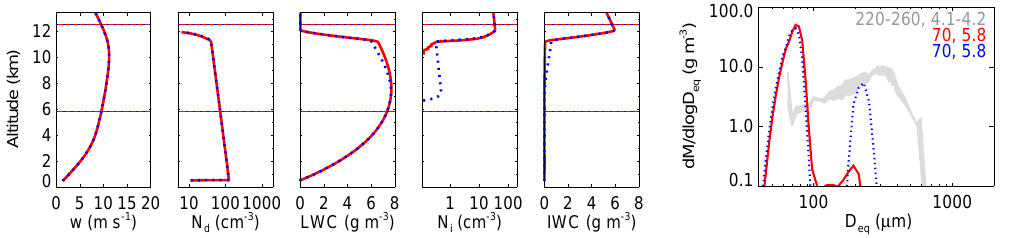
Figure 6. As in Fig. 4 for simulations that also include a pseudo-Hallett–Mossop source producing 1stdcm − 3 splinters with baseline updraft strength scaled by factors of 0.5 (red solid line), 1.0 (blue dotted line, same as in Fig. 5), and 1.5 (green dashed line). Note that vertical scale for ice PSDs is logarithmic in preceding figures so that insubstantial larger mode is evident, but is linear hereafter.